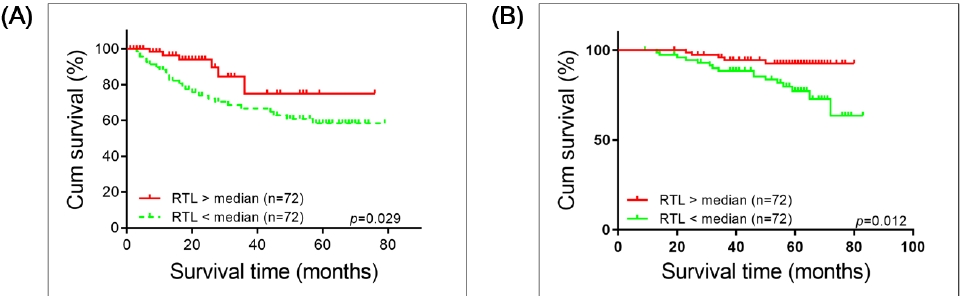
Figure 3. Kaplan–Meier survival analysis of overall survival of patients with ( A ) Bladder Cancer or ( B ) Renal cell carcinoma correlated with long and short relative telomere length (RTL). Significance was determined using log-rank test.